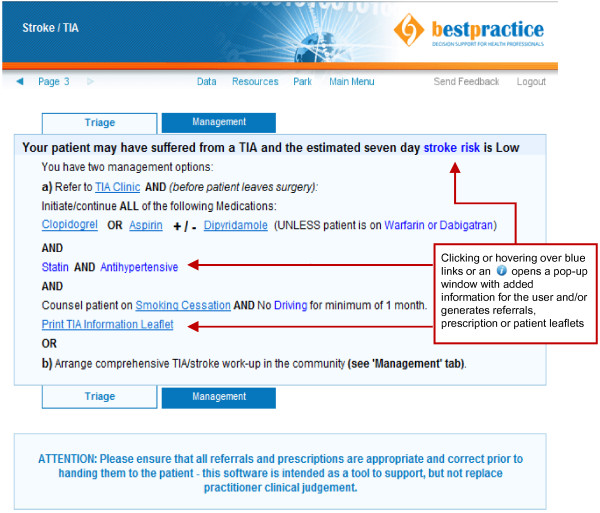
TIA/Stroke electronic decision support sample outcome page for a low risk patient with typical TIA symptoms.